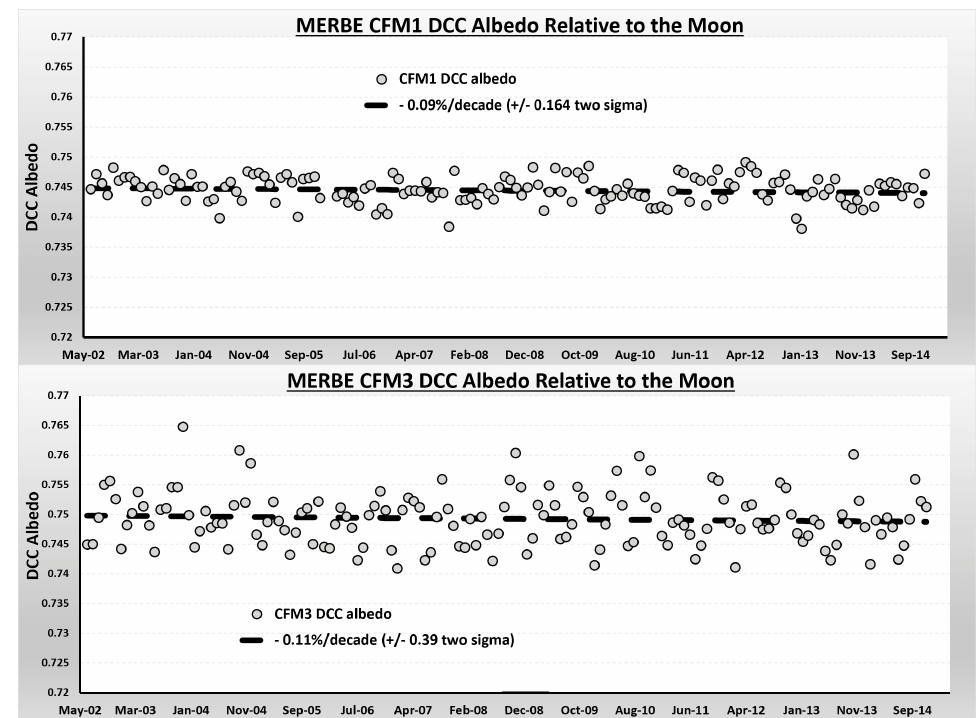
Figure 5. ( Top ): MERBE Terra CFM1 measured DCC Albedo up to 2015. ( Bottom ): MERBE Aqua CFM3 measured DCC Albedo up to